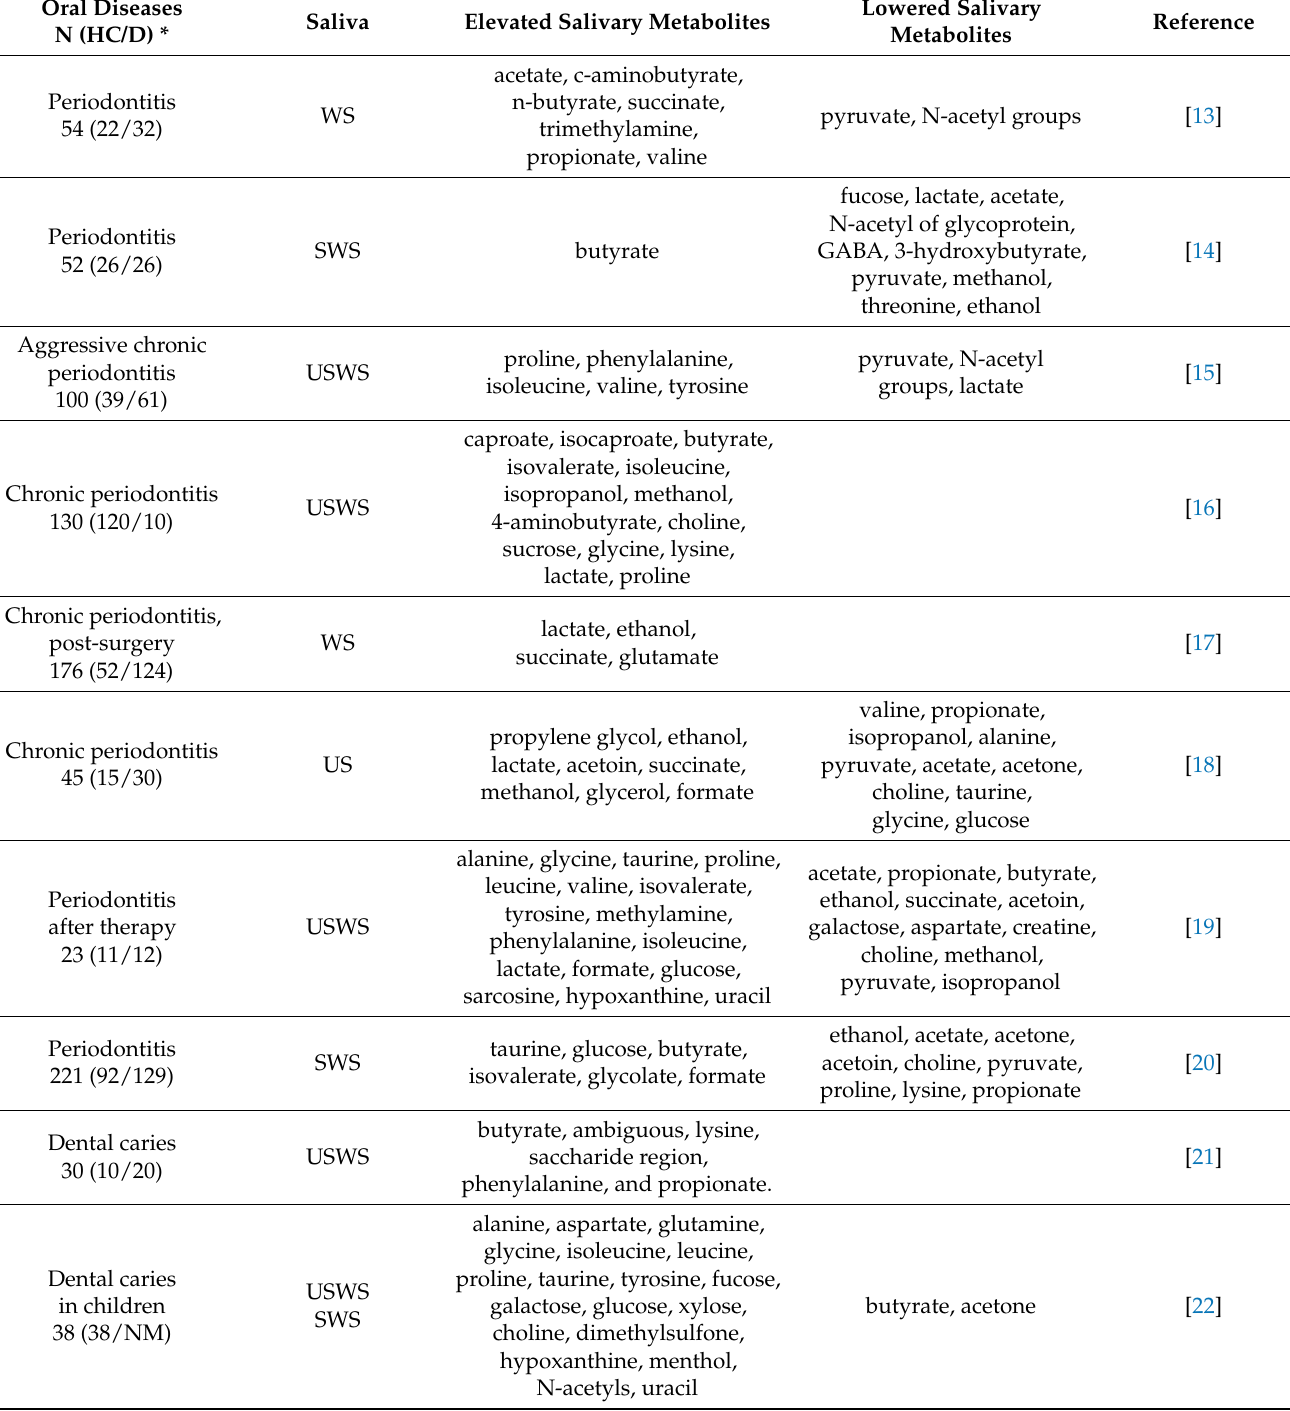
Table 1. Salivary metabolites associated with most common oral inflammatory diseases, caries and periodontitis, based on NMR spectroscopic